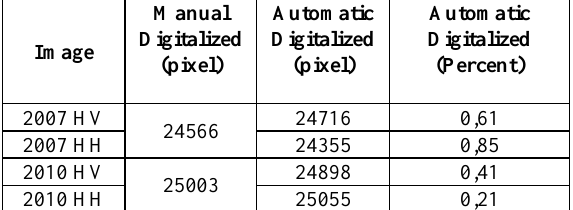
Table 3. Comparison between the lengths of automatically extracted and manually digitized